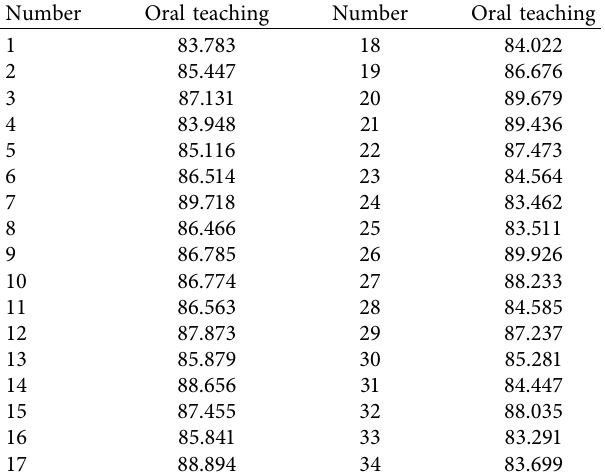
Table 1: Effect verification of the digital teaching platform for spoken English based on virtual